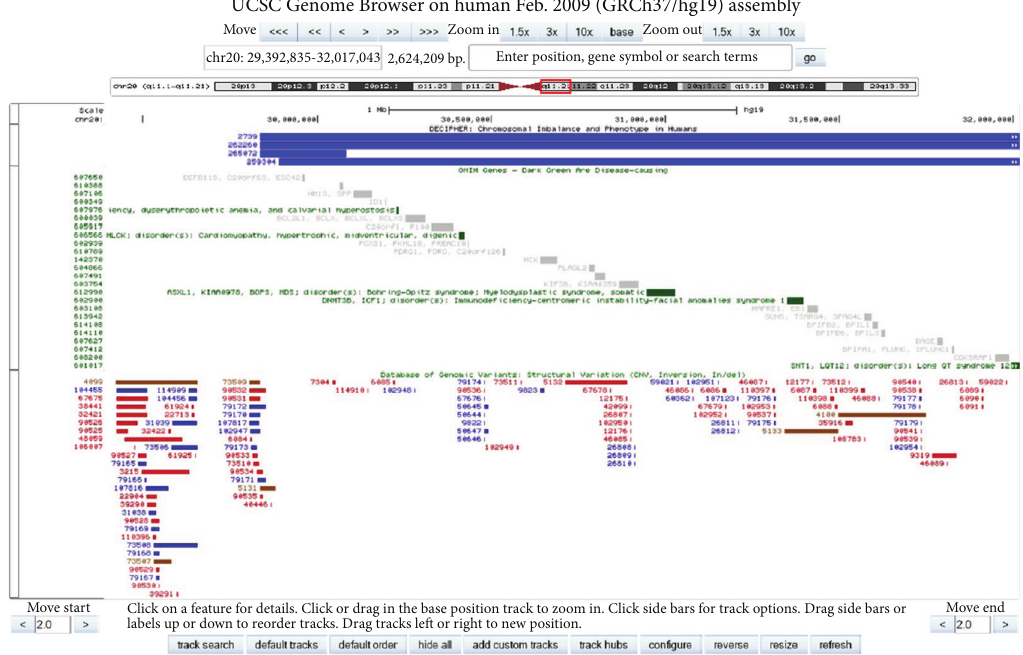
Figure 2: In silico evaluation of the deleted region by UCSC Genome Browser (GRCh37/hg19) (http://genome.ucsc.edu/), including data retrievedfromDECIPHER(databaseofunbalancedchromosomeaberrationshttp://decipher.sanger.ac.uk/),OMIM(http://www.omim.org/) (dark green OMIM genes are disease causing), and Database of Genomic Variants (http://dgvbeta.tcag.ca/dgv/app/home?ref=GRCh37/hg19) (blue bars correspond to a gain in size relative to the reference; red bars correspond to a loss in size relative to the reference; brown bars correspond to both losses and gains in size relative to the